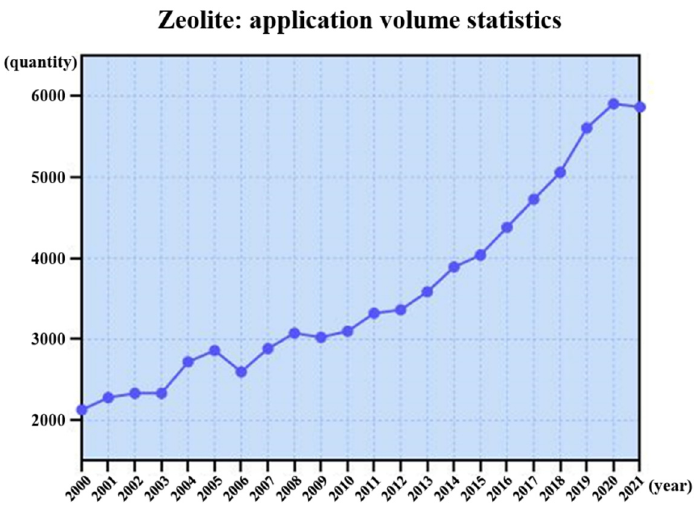
Figure 8. The research quantity curve of zeolite in the past two decades. ZSM ‐ 5 is a medium pore zeolite containing ten ‐ membered rings. The framework is composed of two intersecting channel systems. The short axis is 5.1–5.2 Å; the other is a “Z” ‐ shaped transverse channel with a nearly circular cross ‐ section and a pore diameter of 5.4 ± 0.2 Å. Its unique microporous structure makes ZSM ‐ 5 have excellent shape selectivity and is a commonly used catalyst in the chemical field. ZSM ‐ 5 can be used in a variety of aromatization reactions, such as the methanol ‐ to ‐ aromatics process (MTA). The methanol ‐ to ‐ aromatics (MTA) process is important for converting coal/natural gas to chemicals [95]. Due to its poor electron beam stability, it is difficult to analyze its microstructure by trans ‐ mission electron microscopy [96–98]. In 2016, its deactivation mechanism during the MTA reaction was explored by Prof. Wei’s group by low ‐ dose iDPC ‐ STEM [92]. Figure 9a is a schematic diagram of the catalytic process in MTA. Figure 9b,c is the low ‐ dose HRTEM and iDPC ‐ STEM images. It can be seen that the use of iDPC ‐ STEM technique can achieve more precise characterization of the skeleton structure and explore the inside of the pore. This work has a great breakthrough in the EM characterization of ZSM ‐ 5. The results show that hydrothermal deactivation was mainly caused by the loss of frame ‐ work acid sites and the blockage of channels by extra ‐ framework alumina, provides theoretical guidance for further optimization of MTA process. ( a )